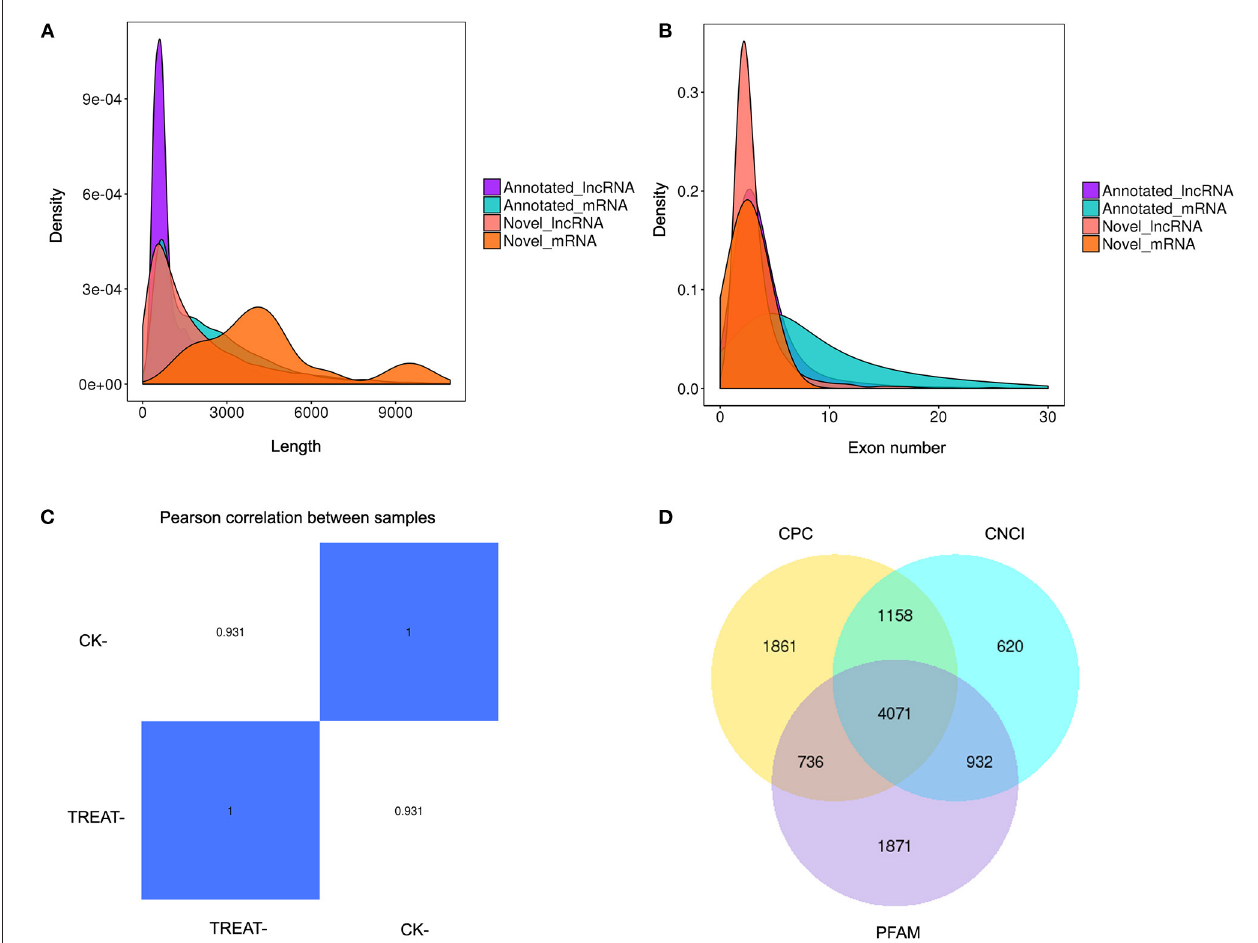
FIGURE 2 | Expression profiling of lncRNAs in the mouse DED model. (A) Histogram showing length distribution of novel lncRNA. (B) Histogram showing the number of lncRNA exons. (C) Heatmap of gene expression correlation; the numerical value refers to the correlation coefficient. (D) Venn diagram presenting overlapping potential lncRNAs of three computational approaches (CPC/CNCI/PFAM). DED, dry eye disease; lncRNAs, long non-coding